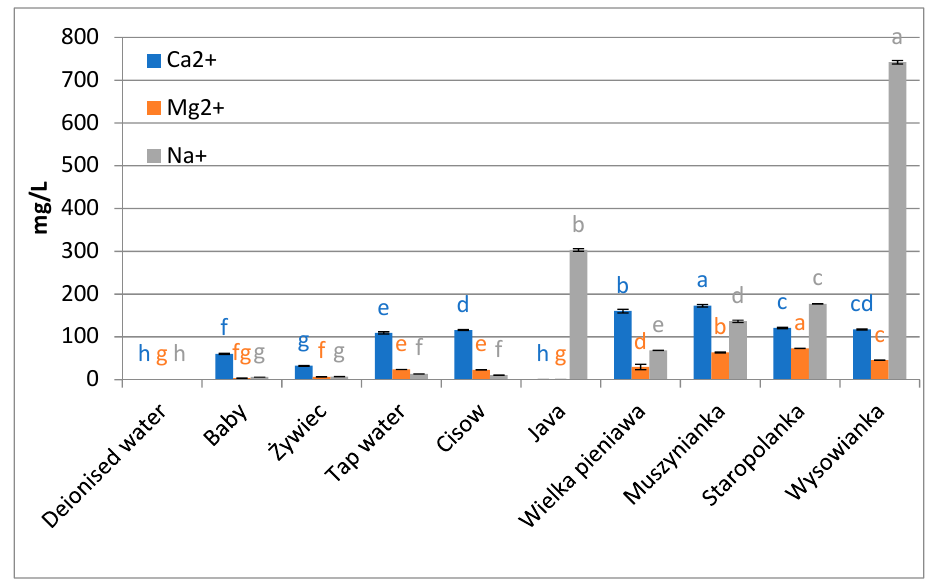
Figure 1. Conductivity, total content of mineral components and hydrogen carbonate ions in se ‐ lected waters. Data are shown as mean ± SD. Different letters (a, b, c, etc.) show a significant dif ‐ ference with p < 0.05. The differences relate to each group of compounds separately .